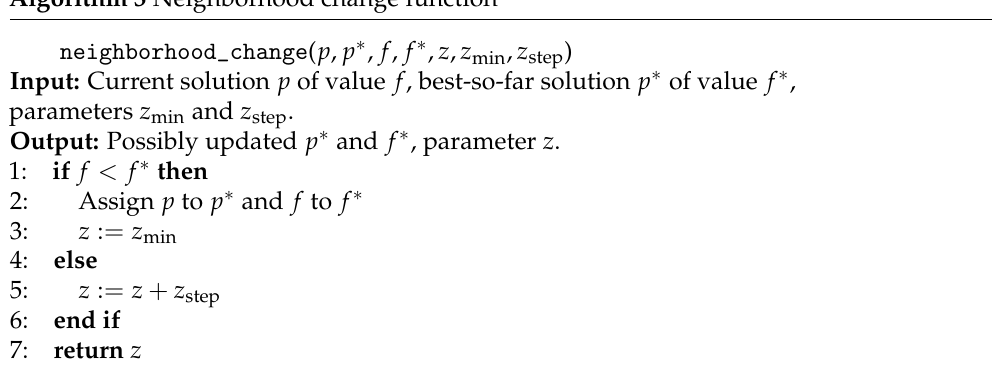
Algorithm 3 Neighborhood change